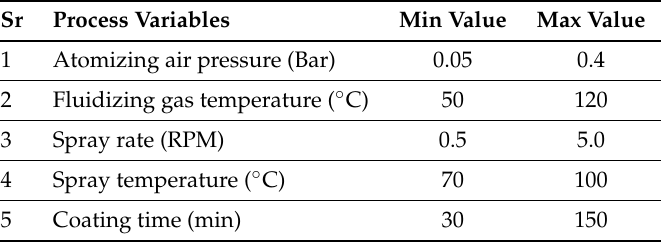
Table 2. Minimum & maximum values of process variables via trial